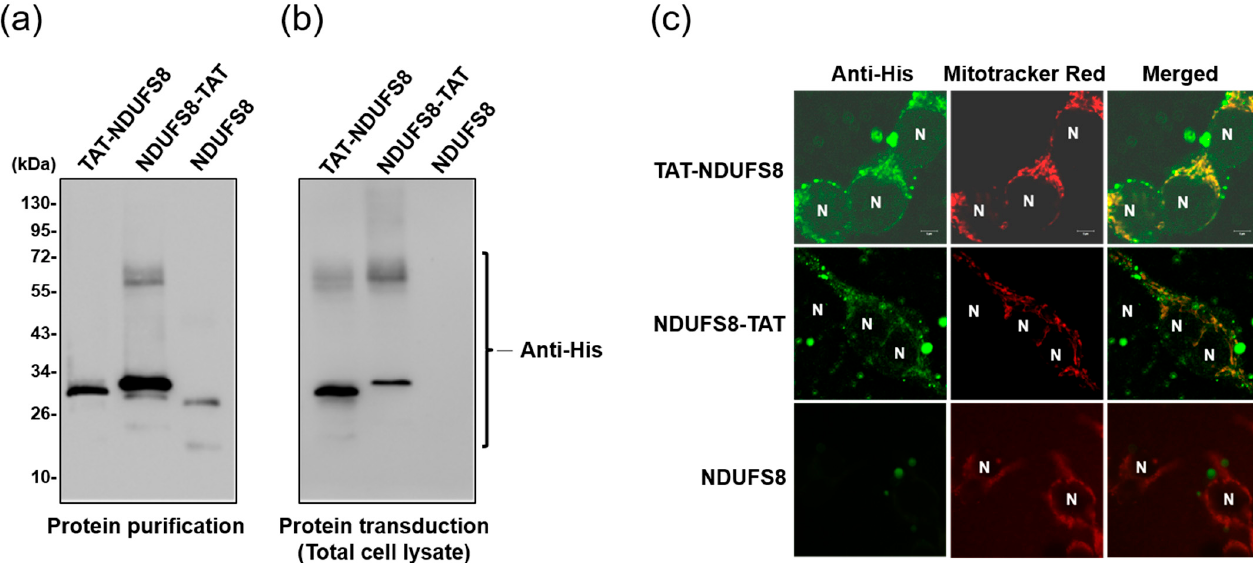
Figure 2. TAT conjugation was required for protein transduction of exogenously produced NDUFS8 into T-REx-293 cells. ( a ) TAT-NDUFS8, NDUFS8-TAT, and NDUFS8 recombinant proteins were overexpressed in E. coli and purified by Co 2+ affinity chromatography. Immunoblotting analysis was conducted on the purified recombinant proteins with anti-His antibody. The effectiveness of TAT conjugation on the delivery of exogenously produced NDUFS8 into cells through protein transduction for 3 h was evaluated by immunoblotting analysis on the total cell lysates with anti-His antibody ( b ), and by immunofluorescence detection with the confocal microscopy on the whole cells ( c ). For immunofluorescence analysis, anti-His primary antibody together with anti-IgG-FITC secondary antibody (green staining) was used to detect NDUFS8-containing recombinant proteins, and Mitotracker Red signal (red staining) was applied to locate mitochondria. N, the nucleus. Scale bar = 5 μ m.